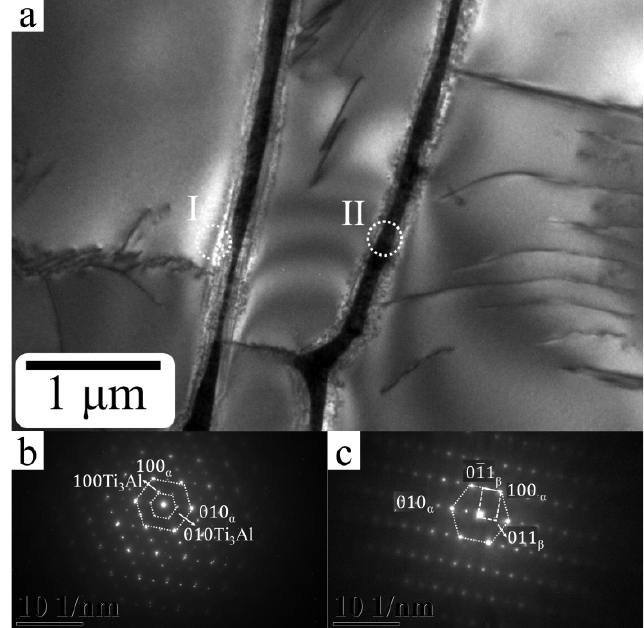
Figure 5. ( a ) Bright field image of ultrafine α + β lamella microstructure found at the center of HED sample. ( b ) Select area diffraction patter from the cycle region (I) in (a) showing the present Ti3Al within an α lamella matrix with crystallographic relationship [001] α // [001] Ti3Al ( c ) Select area diffraction patter from the cycle region (II) in (a) showing the ultrafine α + β lamella microstructure with crystallographic relationship [001] α // [011] β .